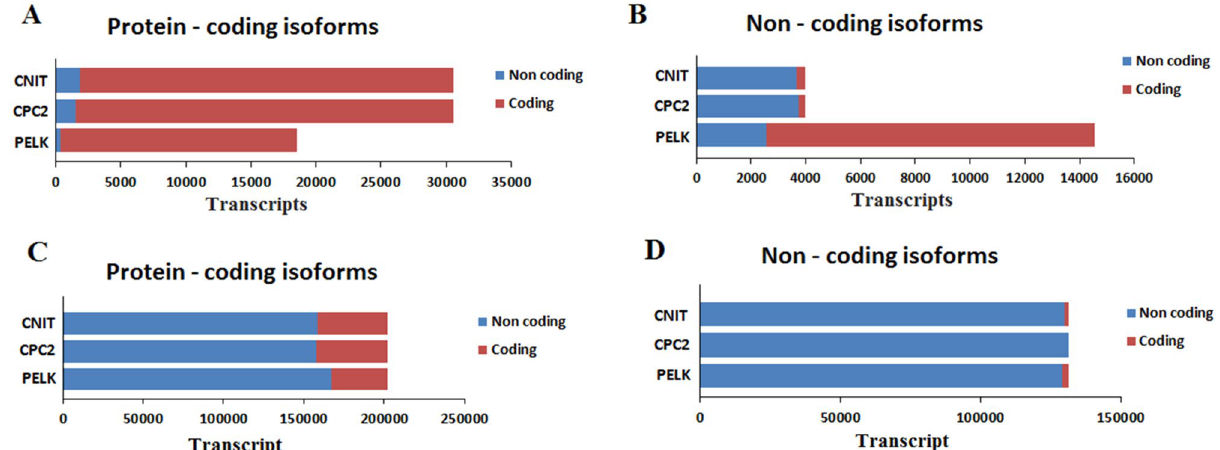
Figure 5. Results of computational approaches on fruit fly and scorpion datasets. ( A , B ) Classification of protein-coding and non-coding transcripts of fruit fly using CNIT, CPC2 and, PLEK tools. ( C , D ) Classification of protein-coding and non-coding transcripts of scorpion using CNIT, CPC2 and PLEK software programs.